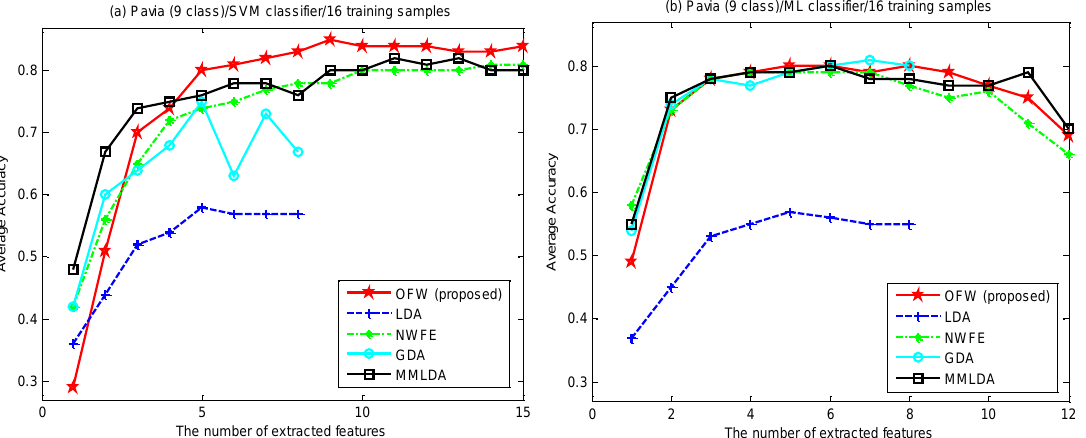
Figure 5. Average classification accuracy versus the number of extracted features obtained by a) SVM, b) ML classifiers for Pavia